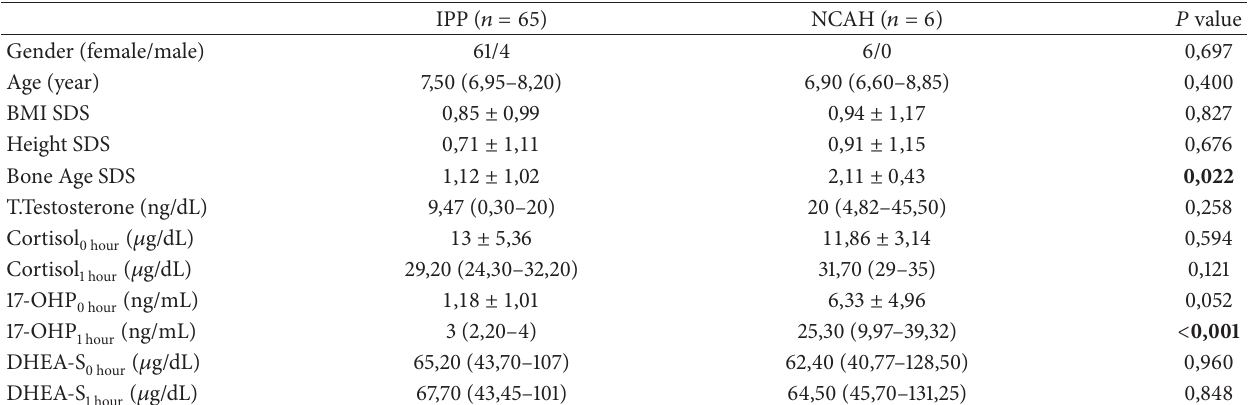
Table 2: Comparisons of clinical and laboratory findings between patients with nonclassic congenital adrenal hyperplasia and premature